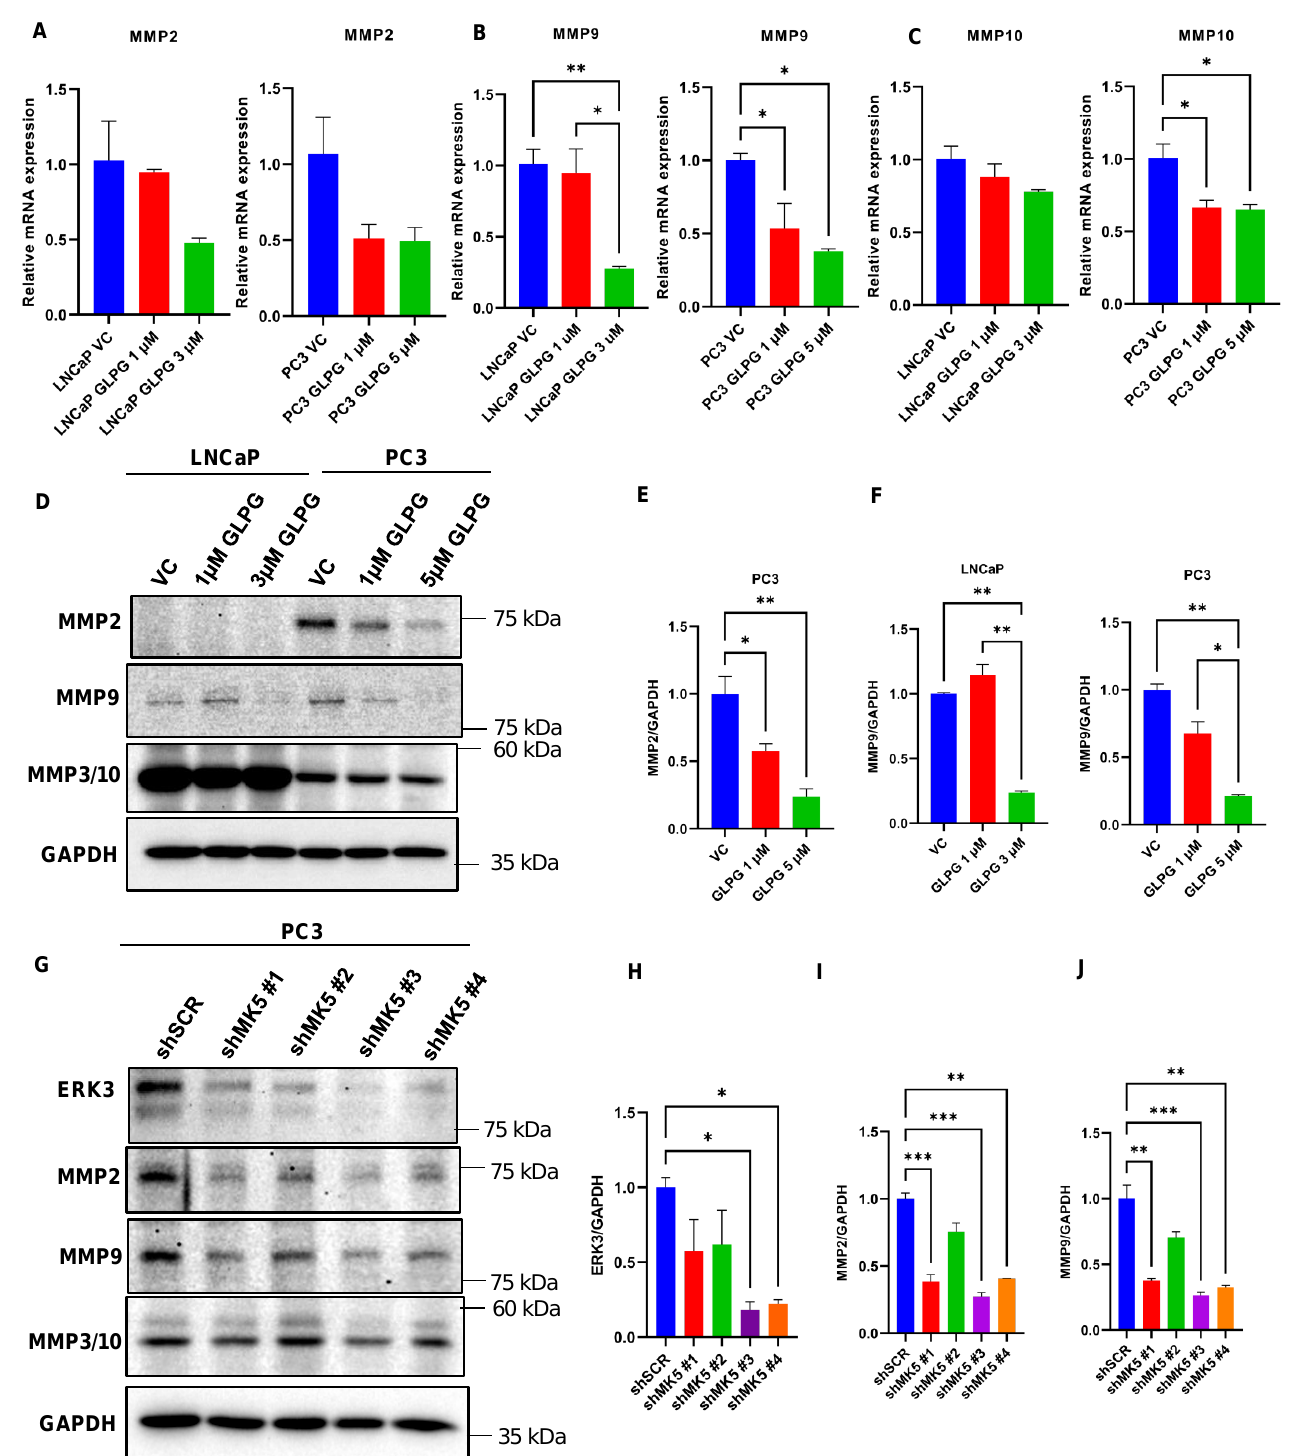
Figure 5. MK5 regulates matrix metalloproteinases’ expression in PC3 cells. ( A – C ) mRNA expres- sion of several matrix metalloproteinases (MMPs): ( A ) MMP2, ( B ) MMP9, and ( C ) MMP10 in LNCaP and PC3 cells treated with different concentrations of GLPG. GAPDH mRNA was used as an internal control. ( D ) Immunoblots of the indicated proteins in LNCaP and PC3 cells treated with different concentrations of GLPG. GAPDH was used as a loading control. Images are the representation